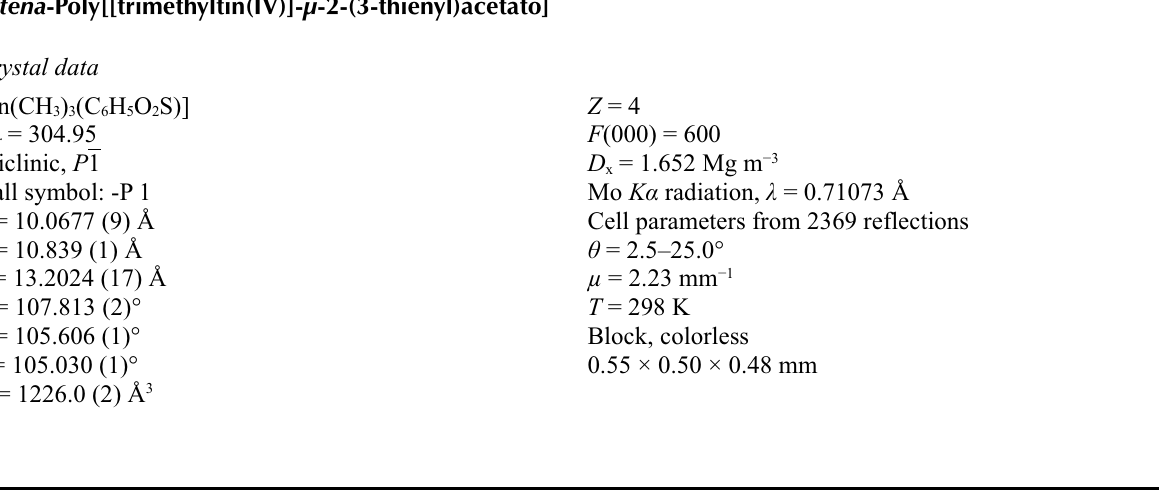
Figure 2 A view of the unit cell showing polymeric chains of (I), H atoms have been omitted for clarity. catena -Poly[[trimethyltin(IV)]- µ